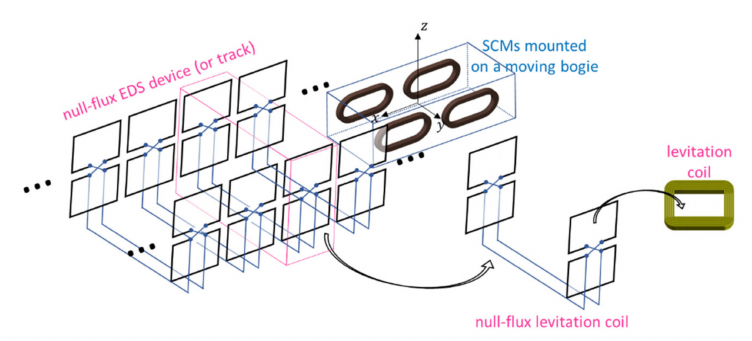
Figure 3. Arrangements of the null-flux levitation coil consisting of null-flux connected coils in the sidewall of the EDS